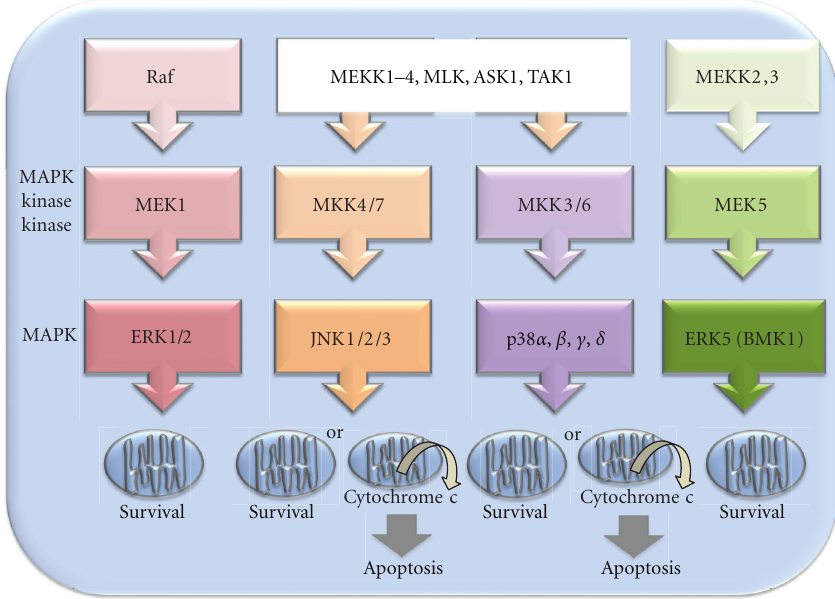
Figure 1: Schematic depicting the activation cascades of the four major MAPK subfamilies and corresponding e ff ects on mitochondrial chromosome c release and apoptosis. ERK1/2 and ERK5/BMK1 have been associated with cell survival, whereas JNK and p38 MAPK have been predominantly associated with